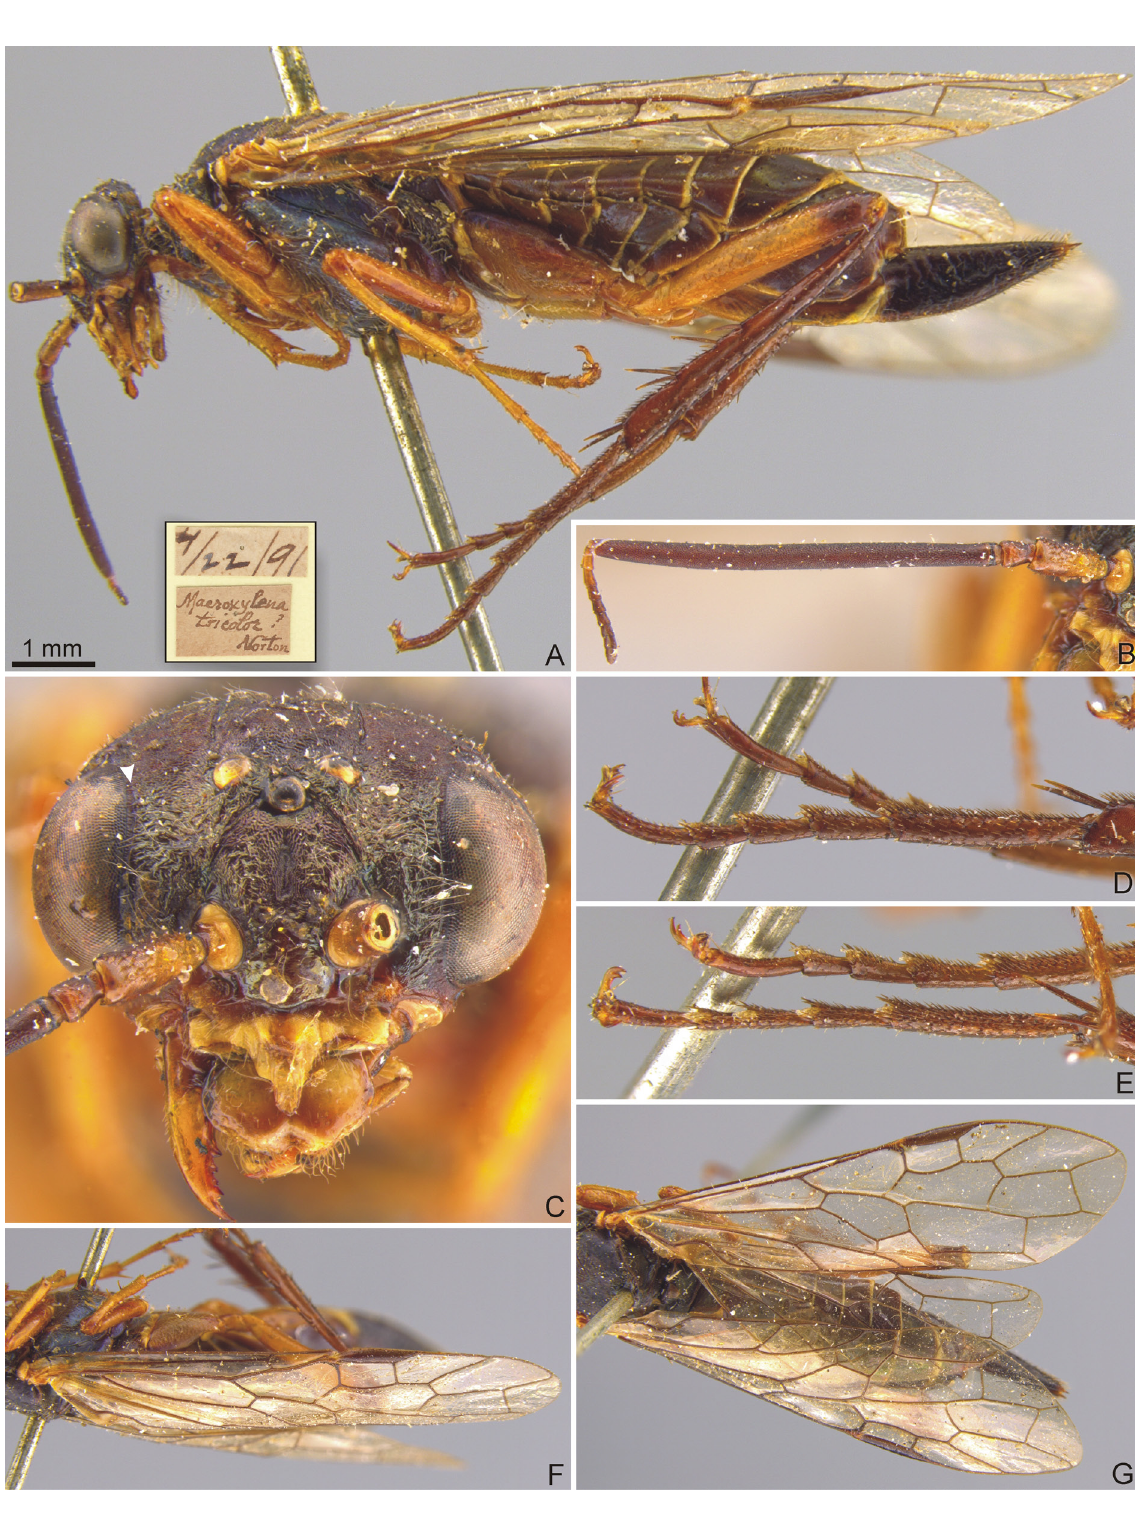
Fig. 6. Megaxyela inversa Blank & D.R. Smith sp. nov. (♀, paratype, DEI-GISHym 22356, USNM). A . Habitus, lateral; small insertion: original collection labels. B . Antenna. C . Head, frontal, arrowhead indicating carina along inner orbit. D–E . Metatarsus, lateral/lateroventral view. F–G .